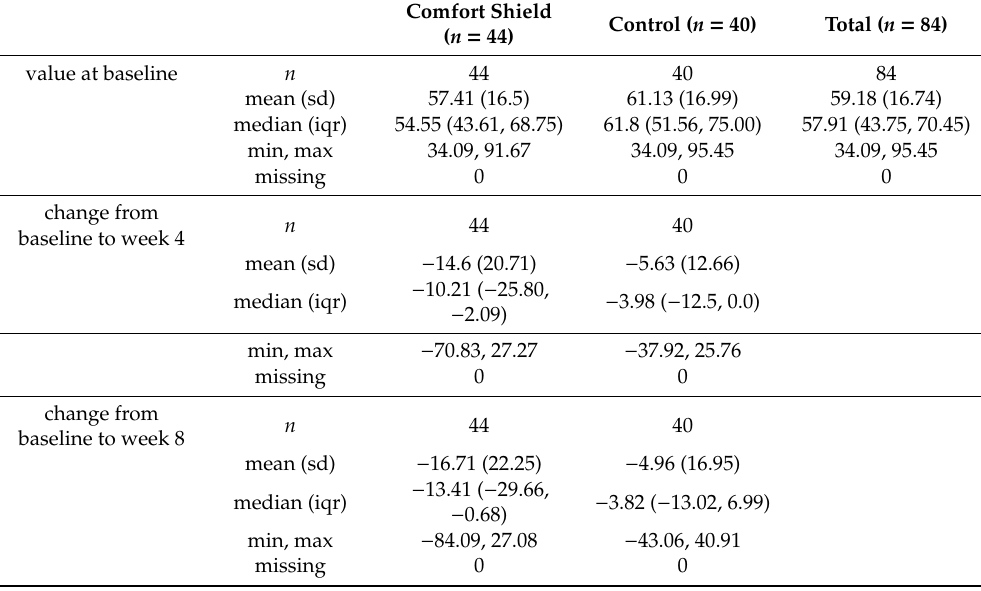
Table 7. OSDI: value at baseline and change from baseline to each post-baseline visit—PPS ( n = 84)—Descriptive analysis, by group.